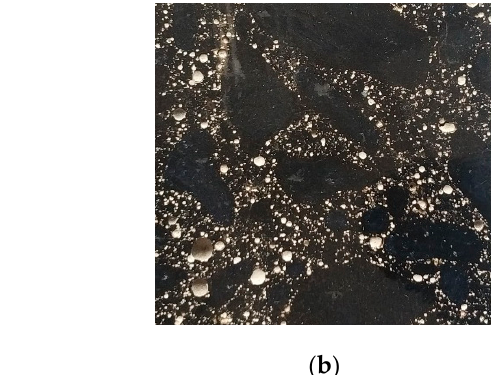
Figure 4. Air-void characteristics test for coal gangue aggregate concrete (CGAC), ( a ) Rapid air concrete air-void analyzer; ( b ) Treated surface of CGAC before air structural testing.